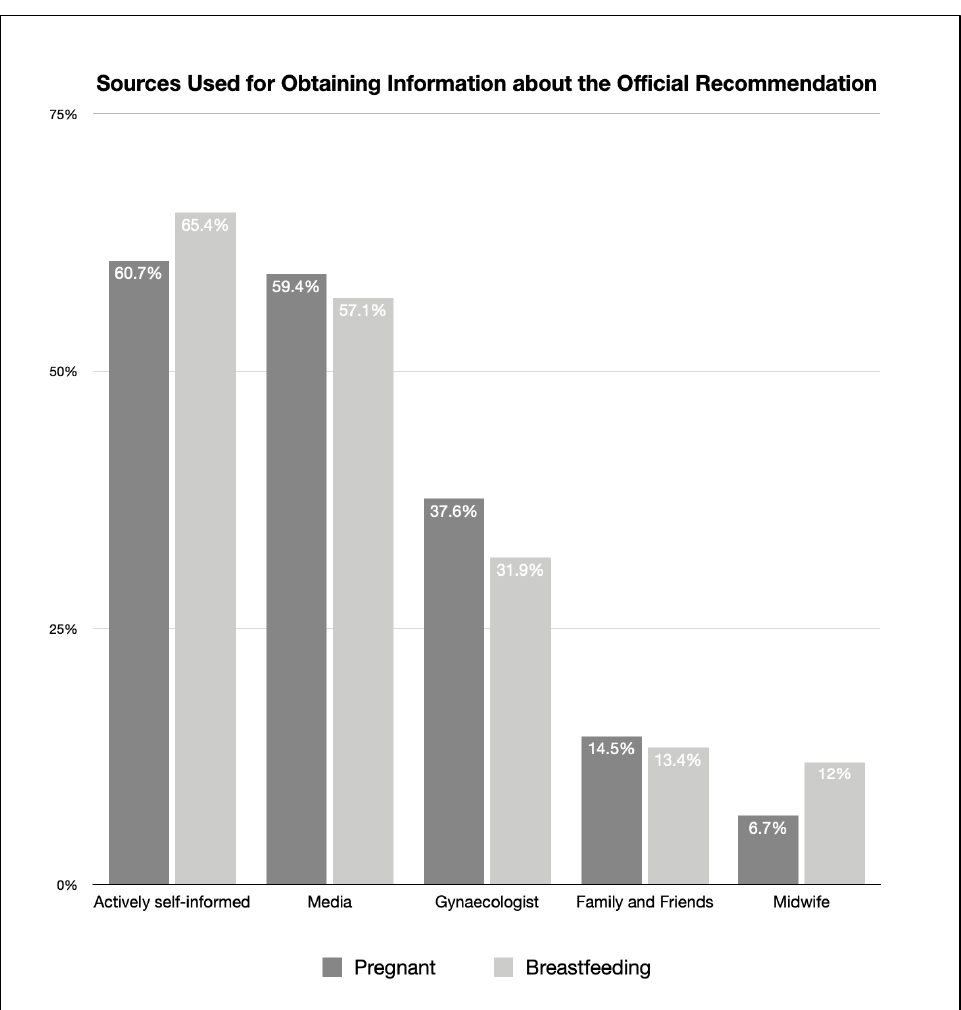
Figure 2. Sources used for obtaining information about the official recommendation (percentage of information sources used by participants after the release of the official recommendation; multiple answers possible).